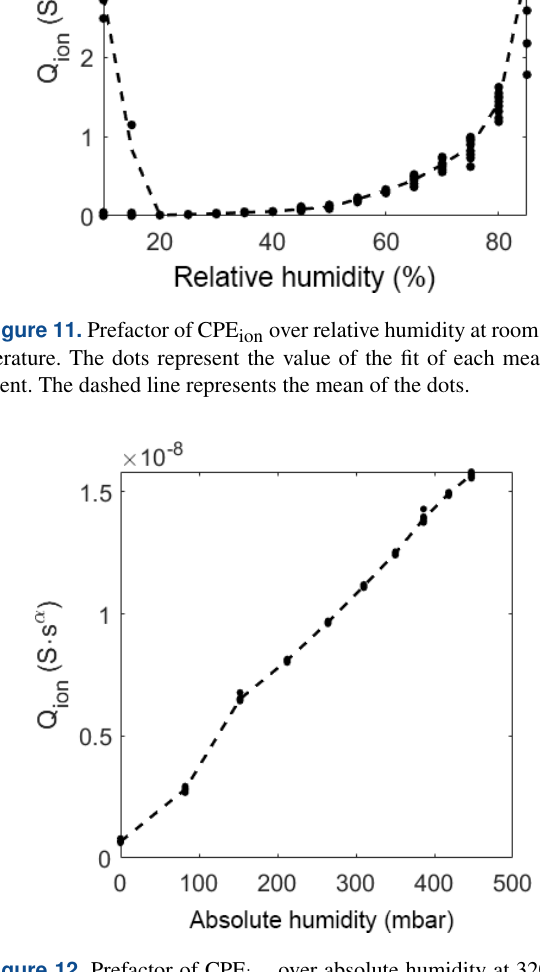
and increases linearly with increasing humidity (Fig. 13).